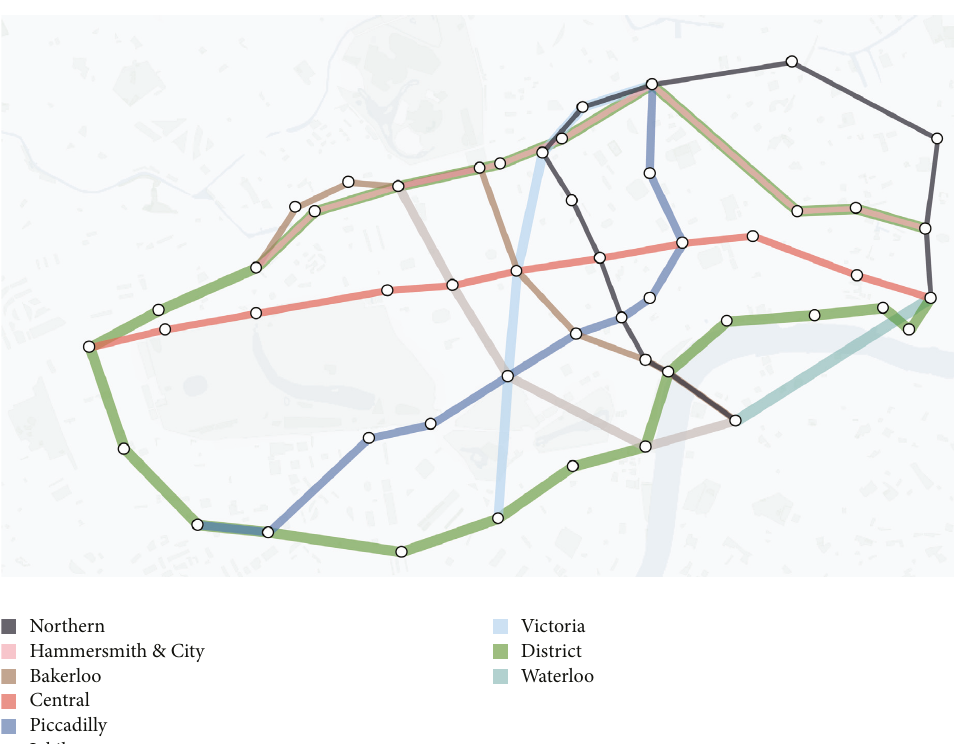
Figure 8: Central London Tube network